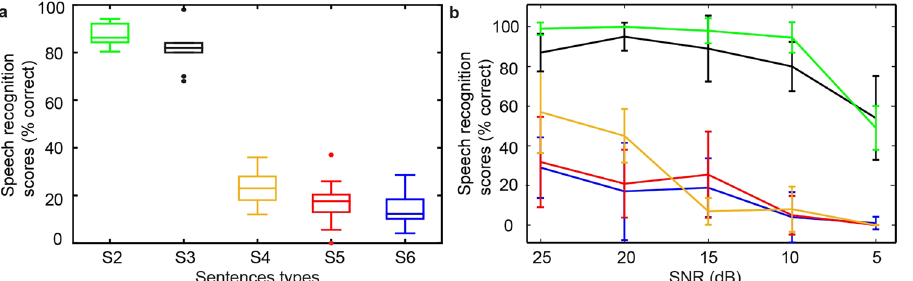
Figure 2. Speech recognition was tested in normal hearing subjects with five types of reconstructed sentences, S2 to S6. The scores for all test subjects for speech in quiet were shown in the box-and-whisker plot ( a ). The maximum, median, minimum, first and third quartiles were also shown in the plot. Dots outside whisker boxes were outliers not included in according boxes, but still considered in comparison. Speech recognition scores were also obtained for speech in noise for five different SNRs: average scores and standard deviations are plotted for all subjects ( b ). Five types of speech files were presented in a random order for each condition to alleviate possible training effects or tiredness of the subjects from the